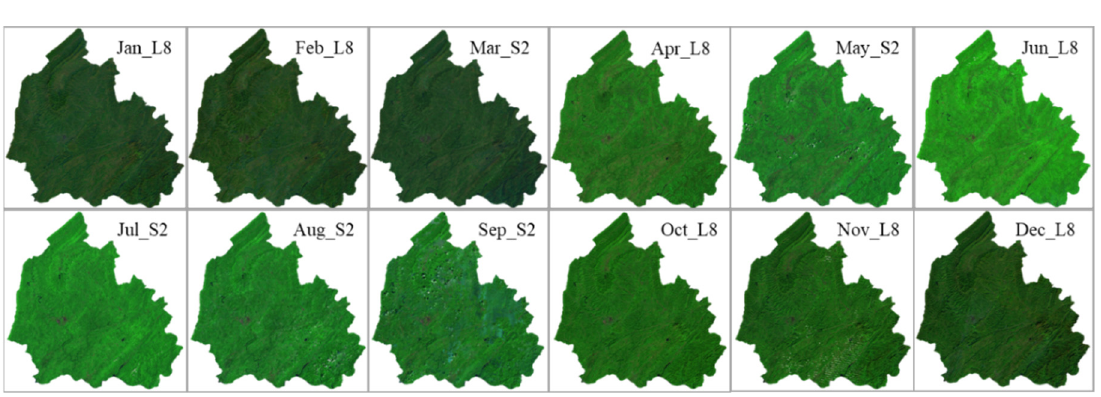
Figure 3. The input time-series images.